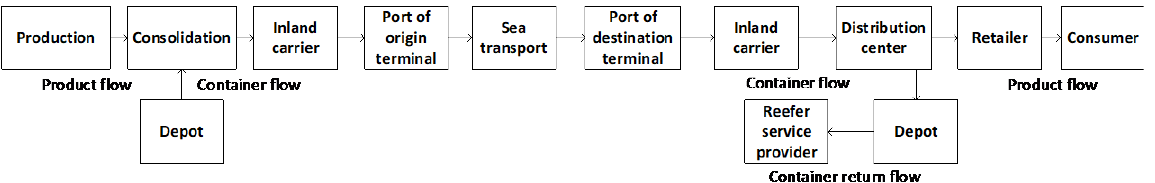
Schematic overview of containerized cold chain processes (source: elaborated from Castelein et al. (2020)